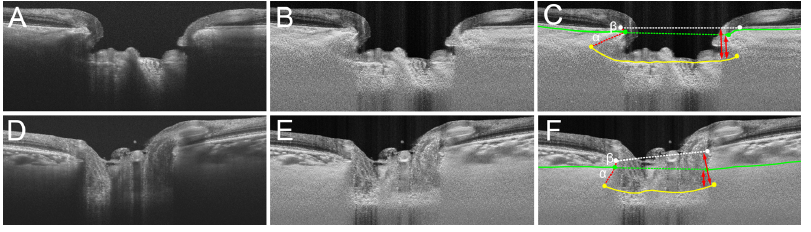
Fig. 6. Comparison of ALID and mALCSD based on Bruch’s membrane opening (white dashed line) and the anterior scleral canal opening (green dashed line) in a glaucomatous eye (A, B, C) and a normal eye (D, E, F). A, D. SS-OCT images without labels. B, E. SS-OCT images after adaptive compensation. C, F. Yellow lines indicate the lamina cribrosa surface, and green lines indicate the anterior scleral surface. ALID measured from Bruch’s membrane opening would be a (red dashed line) + b (red line), while ALID from the anterior scleral canal opening would be a . Note that a + b is similar between C and F ; however, a is noticeably smaller in F than in C . Similarly, mALCSD is much larger in F when it is measured from the level of BMO (longer double arrows), although the depths from the ASCO (shorter double arrows) are smaller in F than in C